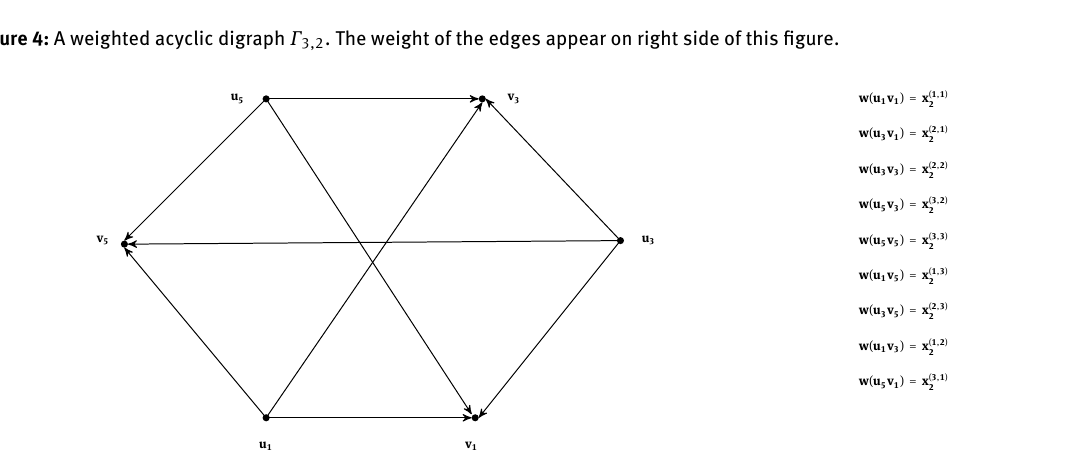
Figure 5: A weighted acyclic digraph Γ 1 . The weight of the corresponding edges appear on